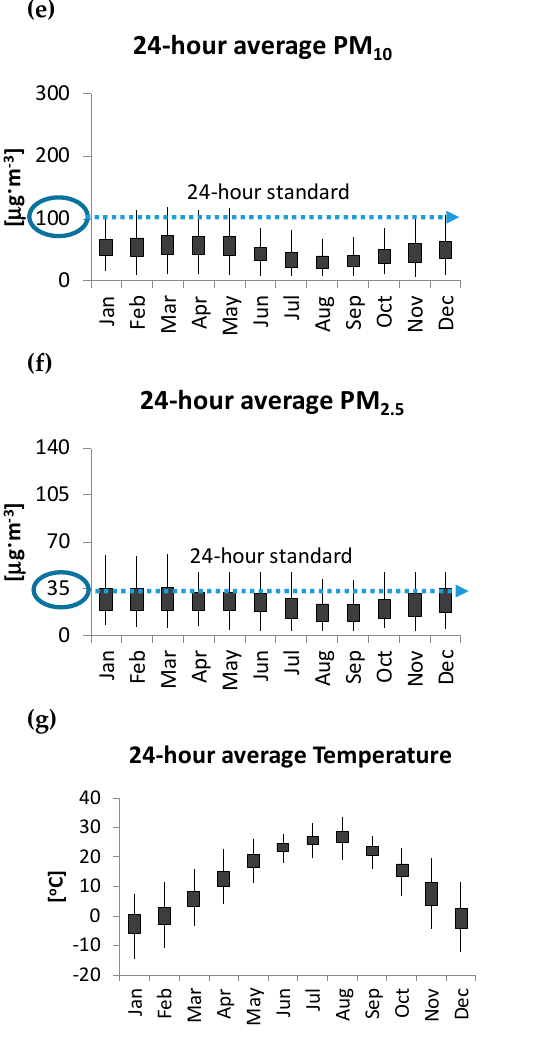
Figure A1. Box plot of 1-h maximum, 8-h maximum, and 24-h average pollutant concentrations, and 24-h average temperatures between 2008 and 2017. ( a ) SO 2 , ( b ) CO, ( c ) O 3 , ( d ) NO 2 , ( e ) PM 10 and ( f ) PM 2.5 , and ( g ) temperature.